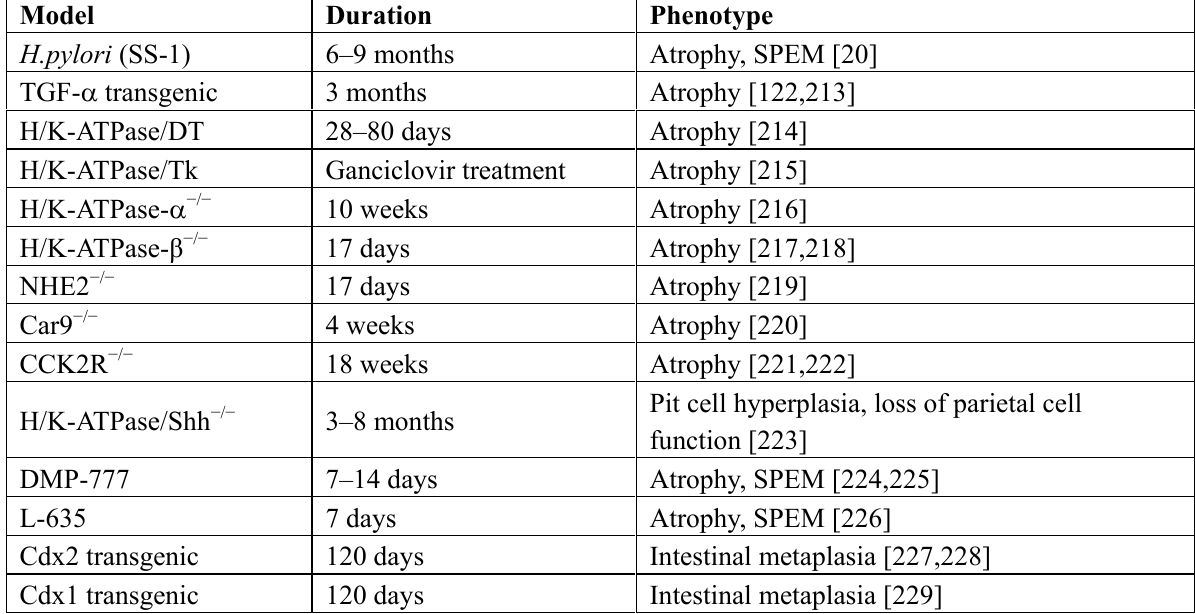
Table 3. Mouse models of precancerous